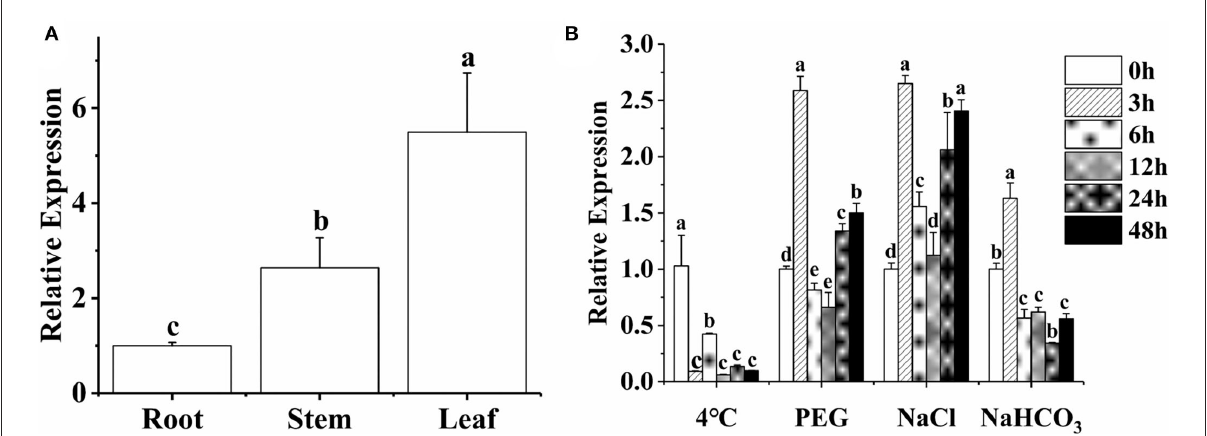
FIGURE2 Expression pattern of MsTHI1 . (A) Tissue-specific expression of MsTHI in the alfalfa root, stem, and leaf. (B) Expression analysis of MsTHI1 in leaves of alfalfa subjected to cold (4 ◦ C), drought (15% PEG), salt (150mM of NaCl), and alkaline (150mM of NaHCO 3 ) stresses. The expression levels were normalized in the alfalfa GAPDH gene. Mean ± standard deviations from three biological replicates are shown with error bars. These letters denote variations that are statistically significant ( α =